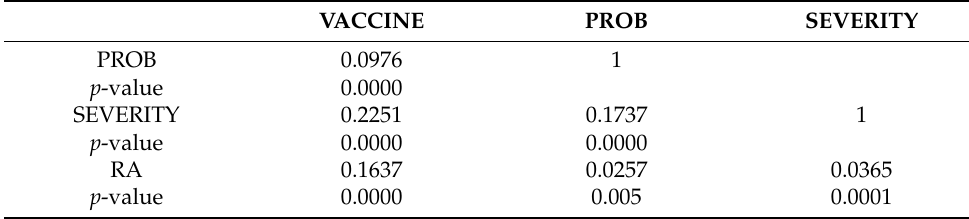
Table 4. Correlation coefficients between variables.